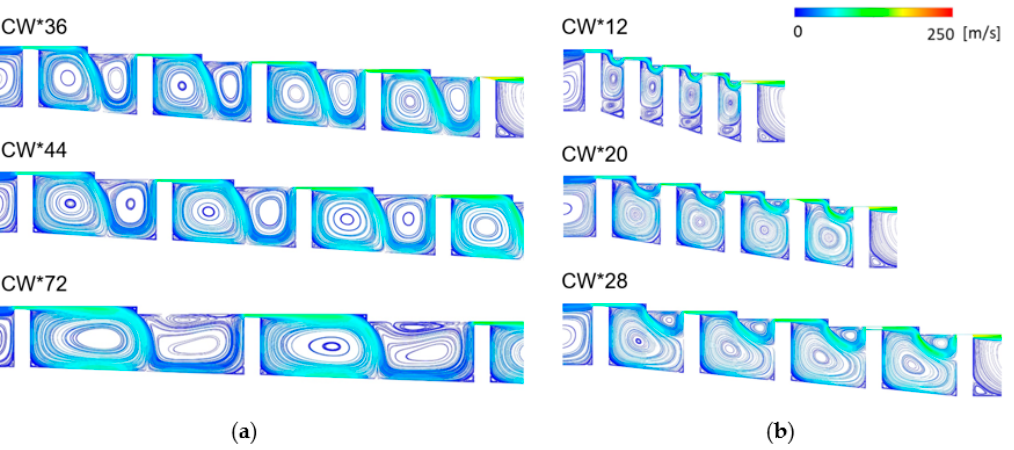
Figure 8. Change in the cavity flow structure according to CW*. ( a ) High ‐ discharge ‐ coefficient group. ( b ) Low ‐ discharge ‐ coefficient group.